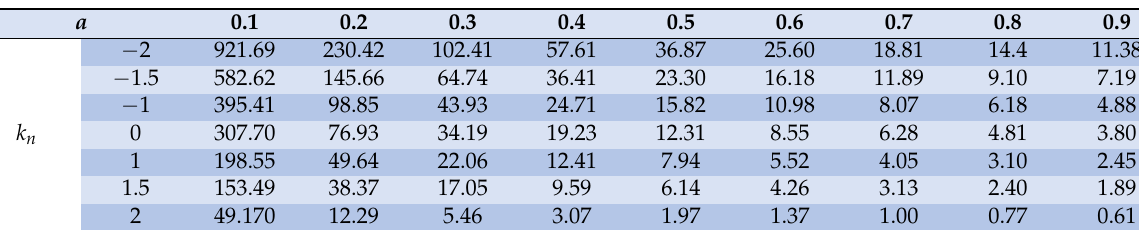
Table 1. Buckling loads vs. k n .